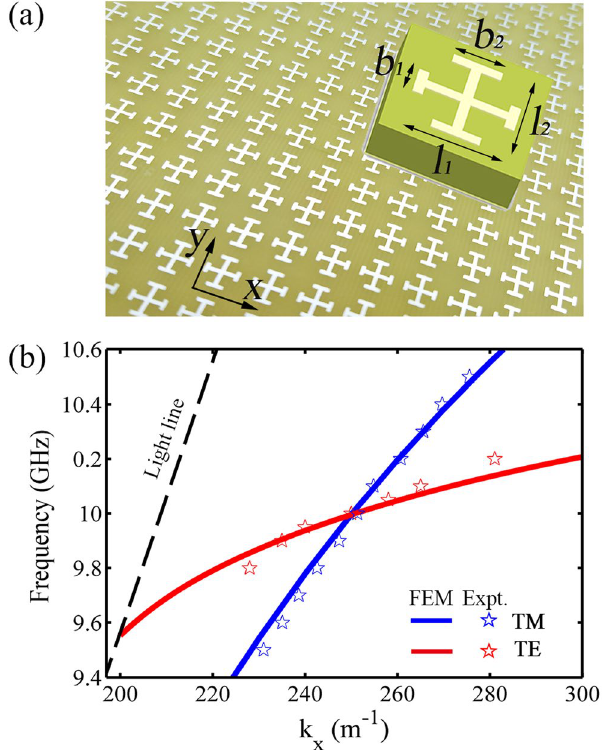
Figure 3. Designs of the artificial plasmonic metal supporting both TE and TM polarized SPPs. ( a ) Sample picture of the plasmonic metal composed by anisotropic mushroom-like structure (sized 7 × 7 mm 2 ) array a flat metal mirror separated by a 2 mm thick dielectric spacer with b 1 = 1.5 mm, b 2 = 2.4 mm, l 1 = l 2 = 4 mm. ( b ) FEM simulated (solid line) and measured (open stars) dispersion relations of TE (red) and TM (blue) polarized spoof SPP modes for the mushroom-like plasmonic metal shown in ( a ). The thickness of the dielectric spacer is 2 mm and the width of the metallic wire is 0.5